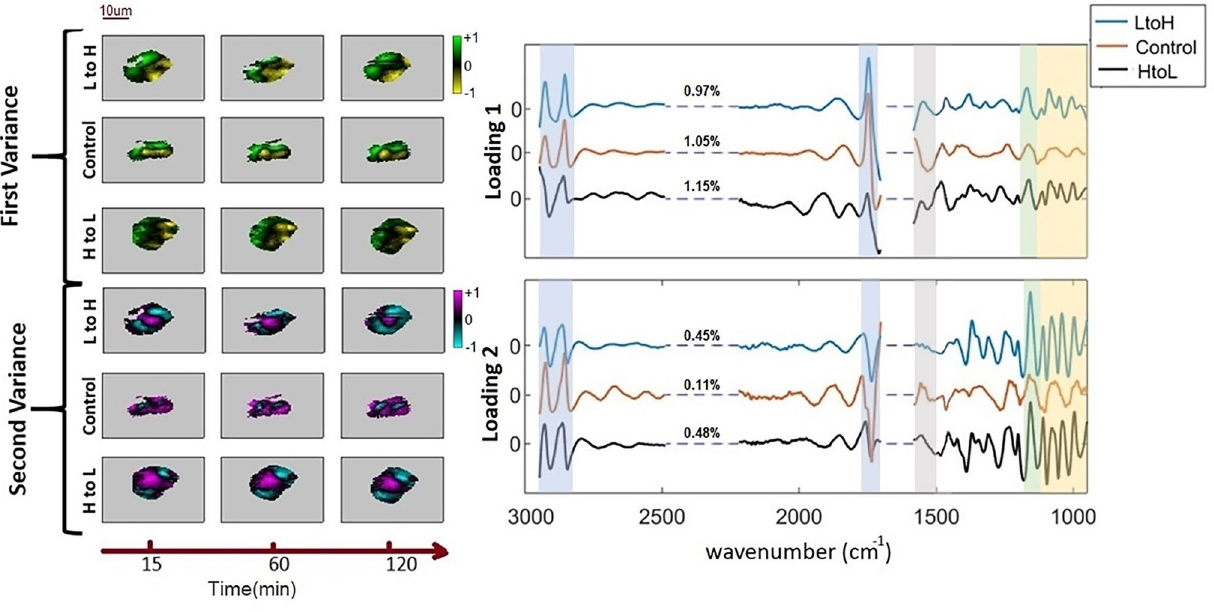
Figure 3. Correlation between spectral features and spatial distribution. Principal component analysis was done for each algal cell separately. Left: PC score images over time (gray indicates the background); right: PC loadings. The percentages on each loading shows the average of the percentage of the total variance explained by each principal component along the replicates of the experiment. Colored vertical bands indicate chemical compounds: orange: carbohydrate, green: DNA–RNA, gray: amide II, blue: lipids; “LtoH” indicates the low (390 ppm CO